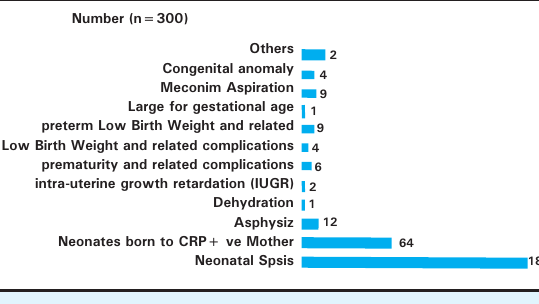
Figure 1. Neonatal morbidities at